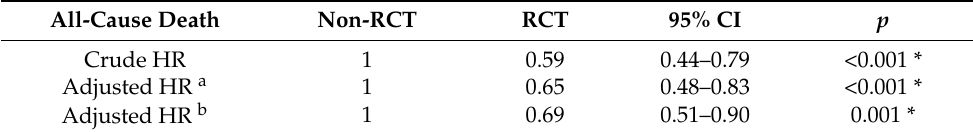
Table 4. Hazard ratios of risk of death among dialysis patients with RCT and without RCT.